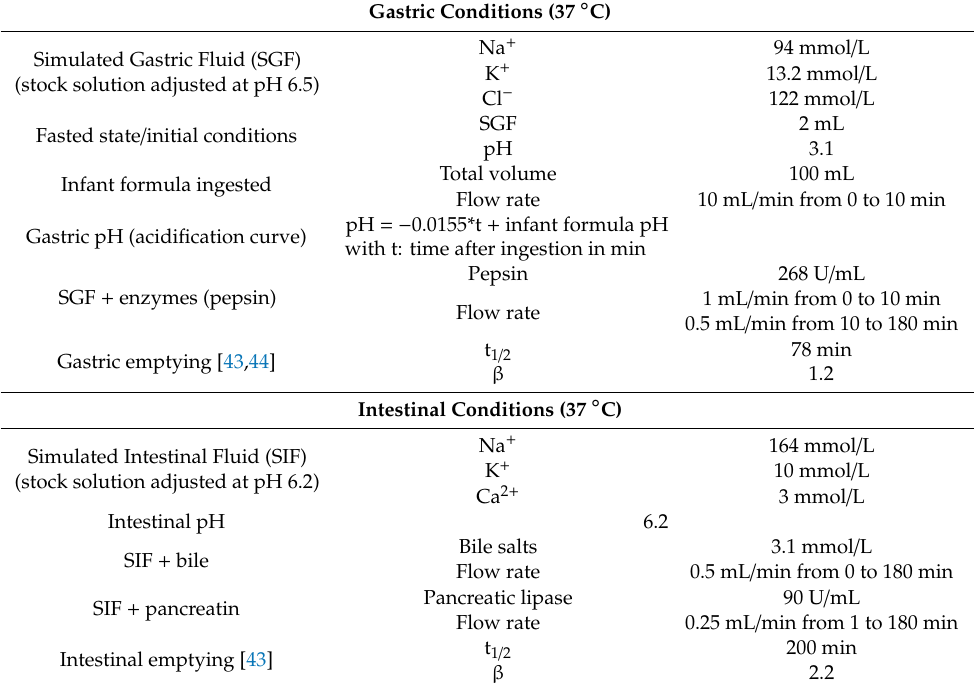
Table 1. Gastrointestinal conditions for in vitro dynamic digestion. Adapted from de Oliveira et al. (2016) [42]. Gastric Conditions (37 ◦ C) Na + 94 mmol / L Simulated Gastric Fluid (SGF) K + 13.2 mmol / L (stock solution adjusted at pH 6.5) Cl − 122 mmol / L SGF 2 mL Fasted state / initial conditions pH 3.1 Total volume 100 mL Infant formula ingested Flow rate 10 mL / min from 0 to 10 min pH = − 0.0155*t + infant formula pH Gastric pH (acidification curve) with t: time after ingestion in min Pepsin 268 U / mL SGF + enzymes (pepsin) 1 mL / min from 0 to 10 min Flow rate 0.5 mL / min from 10 to 180 min t 1 / 2 78 min Gastric emptying [43,44] β 1.2 Intestinal Conditions (37 ◦ C) Na + 164 mmol / L Simulated Intestinal Fluid (SIF) K + 10 mmol / L (stock solution adjusted at pH 6.2) Ca 2 + 3 mmol / L Intestinal pH 6.2 Bile salts 3.1 mmol / L SIF + bile Flow rate 0.5 mL / min from 0 to 180 min Pancreatic lipase 90 U / mL SIF + pancreatin Flow rate 0.25 mL / min from 1 to 180 min 200 min t 1 / 2 Intestinal emptying [43] β